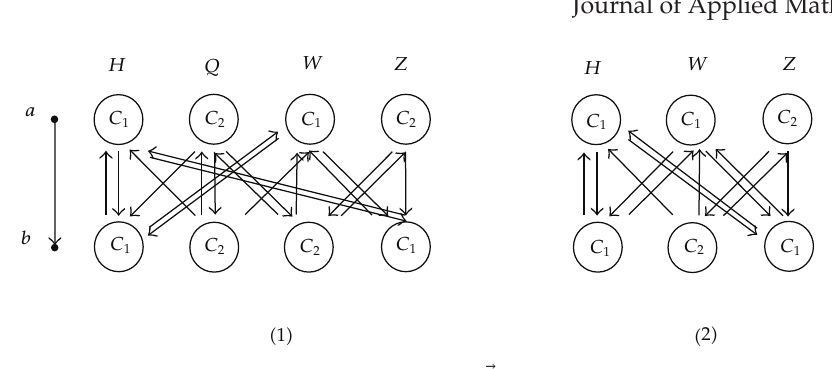
Figure 2: Partition of V (cid:3)